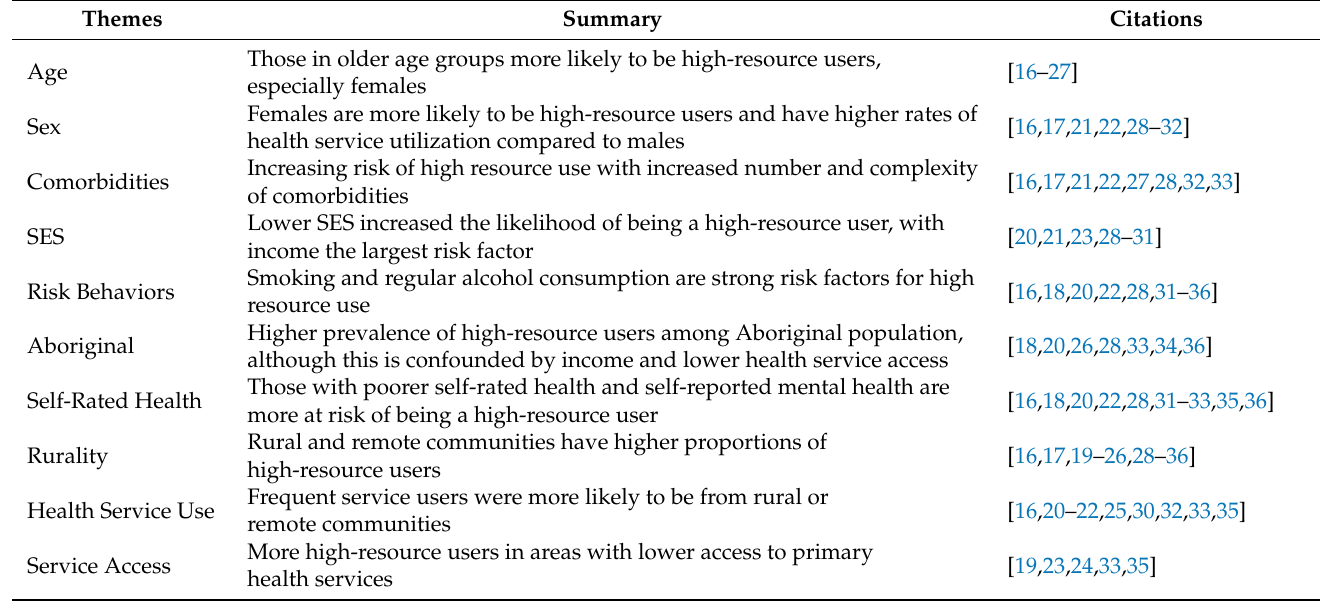
Table 1. Summary of individual and community-level